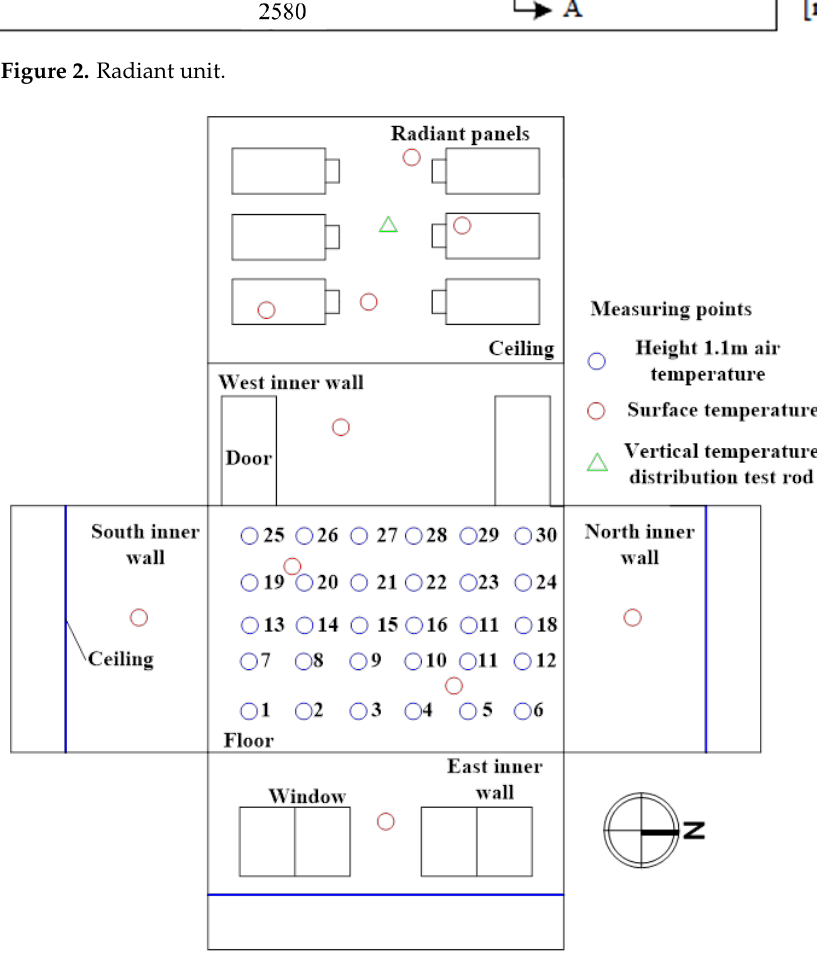
Figure 3. Layout of laboratory measuring points.